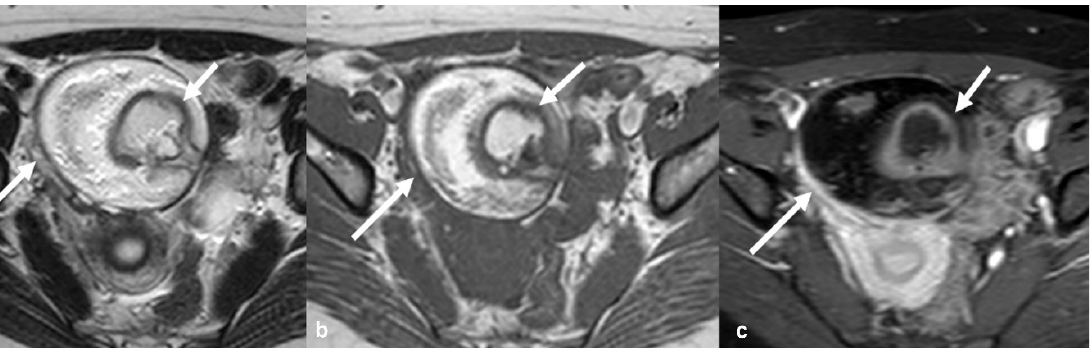
Figure 17. Mature teratoma. Axial T2 weighted image ( a ) shows a large, high signal intensity mass (long white arrow) in the right side of the pelvis. The mass demonstrates high signal intensity on corresponding axial T1 weighted image ( b ) and significant signal drop on T1 weighted FS CE image ( c ), typical of fatty content (long white arrow). Shown also is the typical fat-containing intra-tumoral Rokitansky nodule (short arrow in ( a ) and ( b )) with peripheral contrast enhancement (short arrow in ( c )).